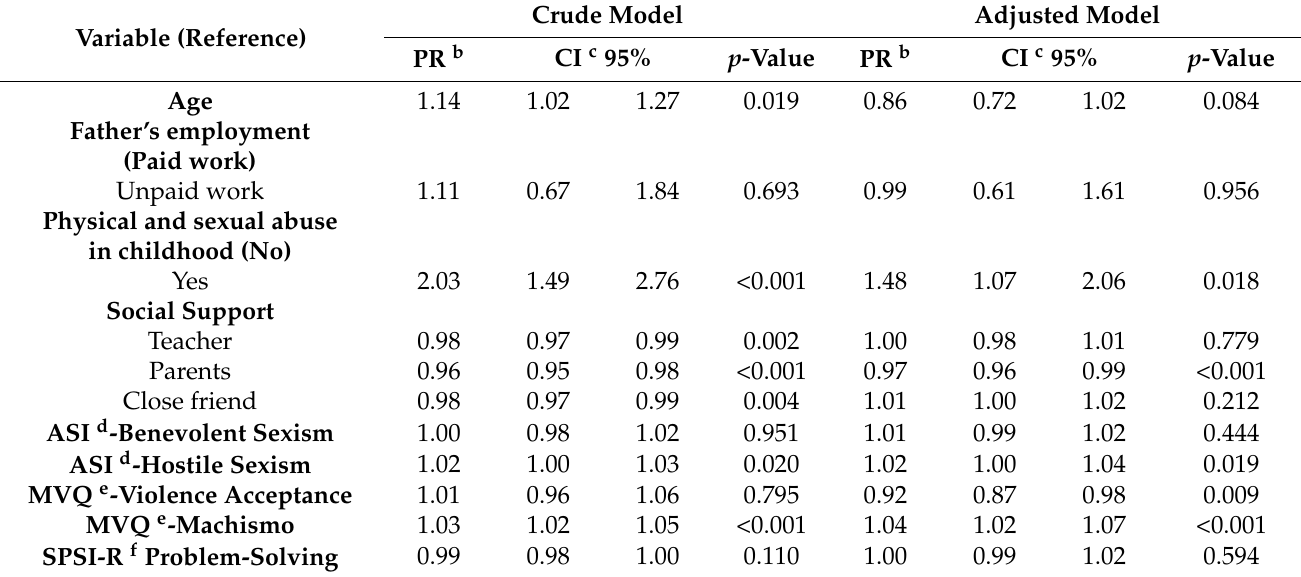
Table 4. Factors Associated with Dating Violence Among Boys Ages 13–16 From Alicante, Spain ( n = 255), Rome, Italy ( n = 285), Iasi, Romania ( n = 343), Matosinhos, Portugal ( n = 259), Poznan, Poland ( n = 190) and Cardiff, UK ( n = 204), 2018–2019